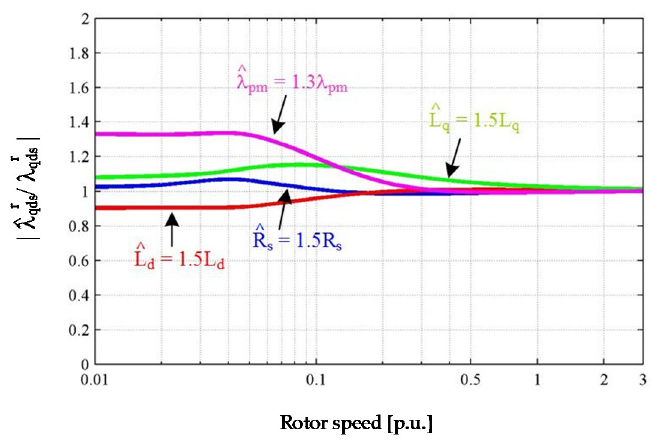
Figure 5. Simulation results of a frequency response of the stator flux linkage observer with respect to motor parameter variations [25].